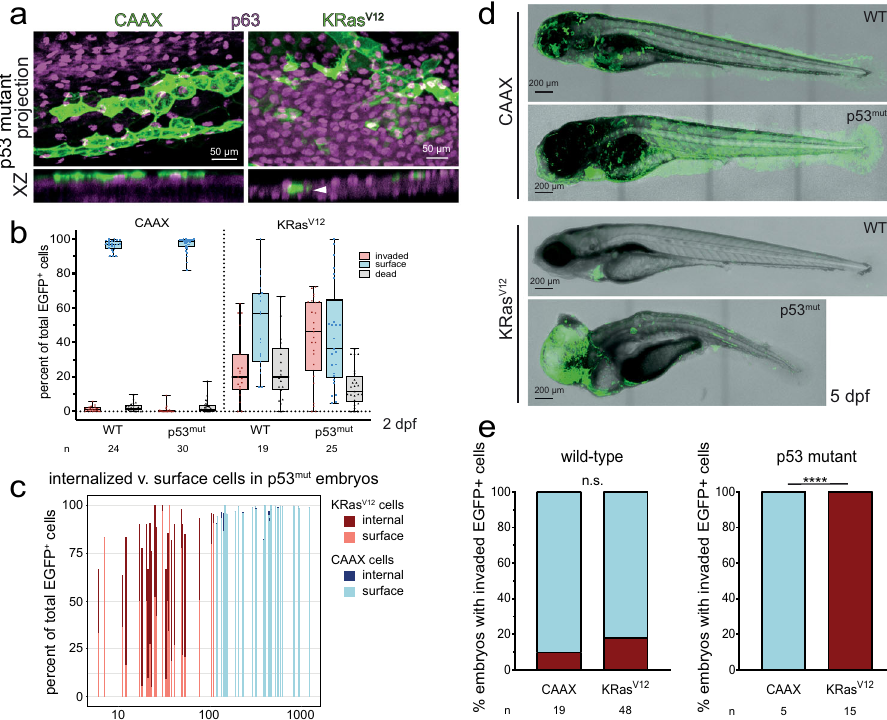
Fig. 2 p53 loss increases survival of internalized KRas V12 cells in the zebra fi sh body. a Maximum intensity and XZ projections of EGFP-CAAX- or dt- KRas V12 -injected p53mut 48 hpf embryos. The white arrowhead indicates a KRas V12 cell internalized beneath p63 + basal keratinocytes. b Quanti fi cation of invaded vs surface (live + dead) EGFP-CAAX or dt-KRas V12 cells in wild-type or p53mut embryos, expressed as a percentage of total EGFP + cells for each embryo, n = embryos, *** P < 0.001 by a Chi-Square test. Data are represented as boxplots where the middle line is the median, the lower and upper hinges correspond to the fi rst and third quartiles, and the whiskers extend from the minimum to the maximum. All data points are shown. c Percentage of internalized or surface cells in CAAX or dt-KRas V12 48 hpf embryos compared to total EGFP + cells in each embryo ( X -axis, log scale), where each line represents an individual p53mut embryo from ( b ). d Wild-type or p53mut larvae at 5 dpf expressing EGFP-CAAX or dt-KRas V12 . Note that the cmlc2 :GFP heart cells represent a Tol2 transgenesis marker, unrelated to CAAX or KRas V12 expression. e Percentages of 5 dpf larvae containing surface or